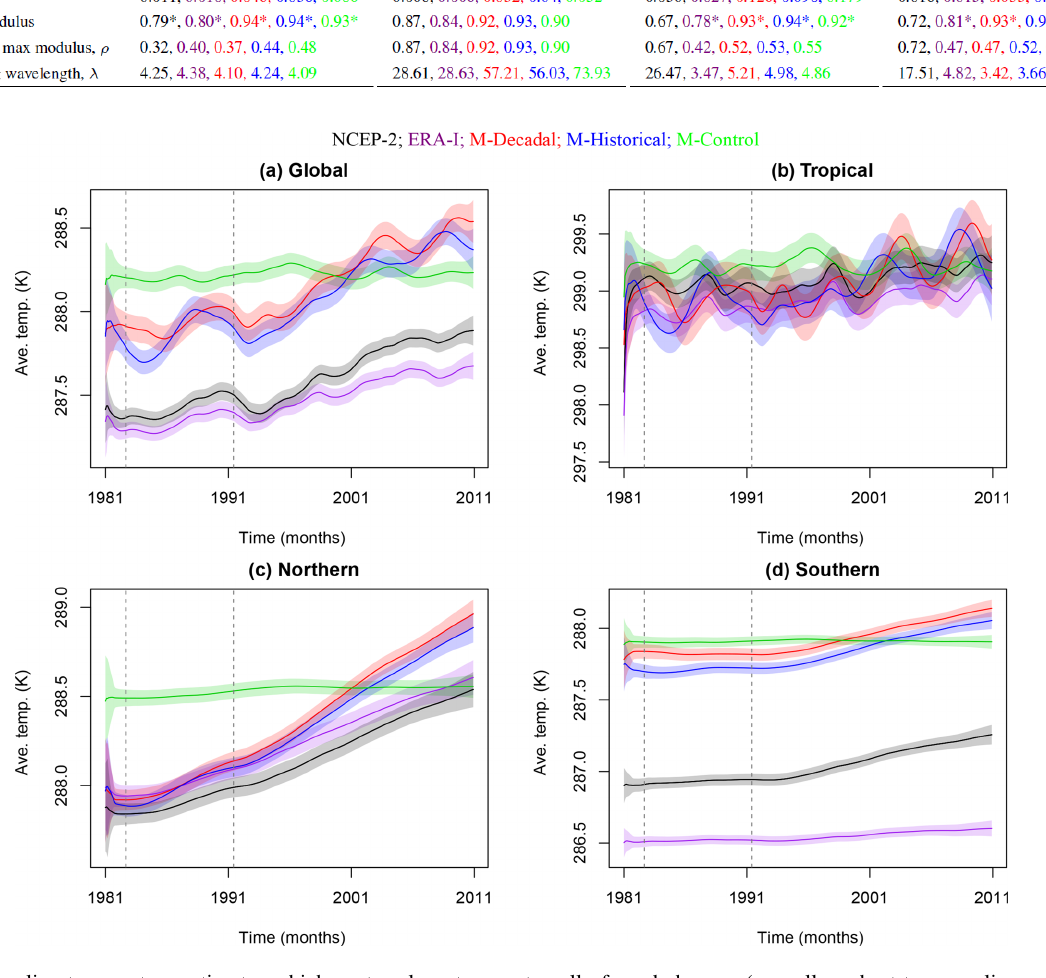
Figure 2. Baseline temperature estimates which capture long-term externally forced changes (as well as short-term cooling responses to volcanic eruptions). Different line colors denote the type of simulation and the reanalysis product. The top panels represent global (a) and tropical (b) regions; the bottom panels represent the Northern (c) and Southern hemispheres (d) . Vertical lines indicate the volcanic eruptions of El Chichón in 1982 and Pinatubo in